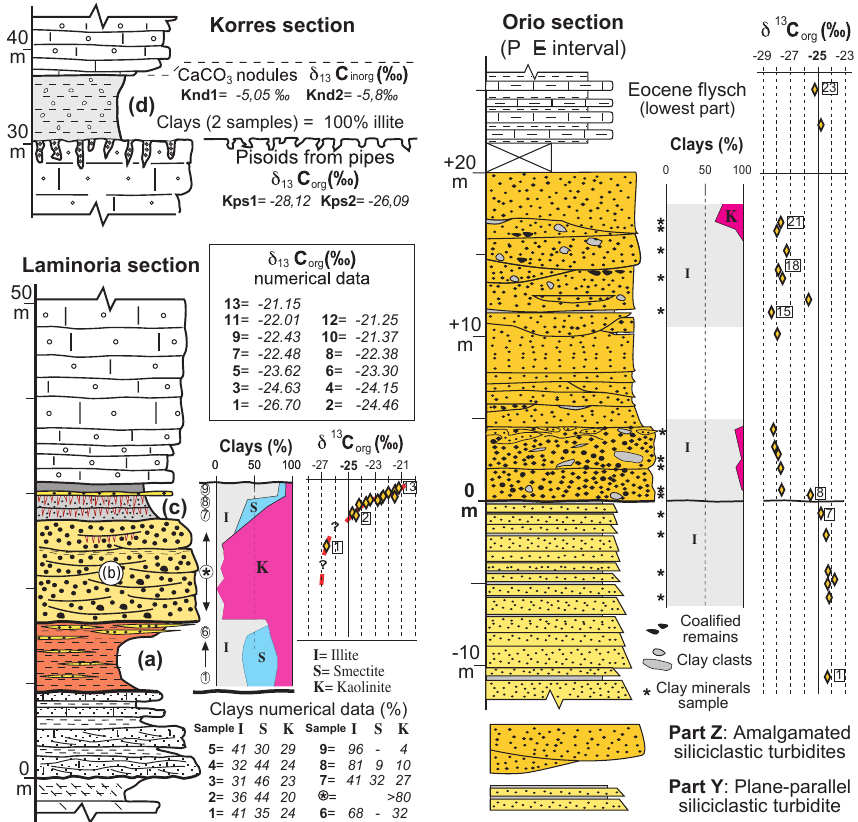
Figure 11. Clay mineral and C stable isotope profiles across the P–E interval of the Korres, Laminoria and Orio sections. The C isotope data from the Orio section are also listed in Table 1. Biostratigraphic data for the Korres and Laminoria sections are given in Fig. 4 and for the Orio section in Fig.